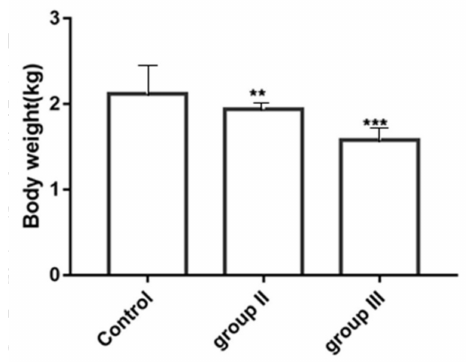
Figure 7. Influence of ALV-K infection on body weights in Specific-pathogen-free (SPF) chickens. Mean weight was significantly different between the groups ( p < 0.01). ** p < 0.01, *** p < 0.001.